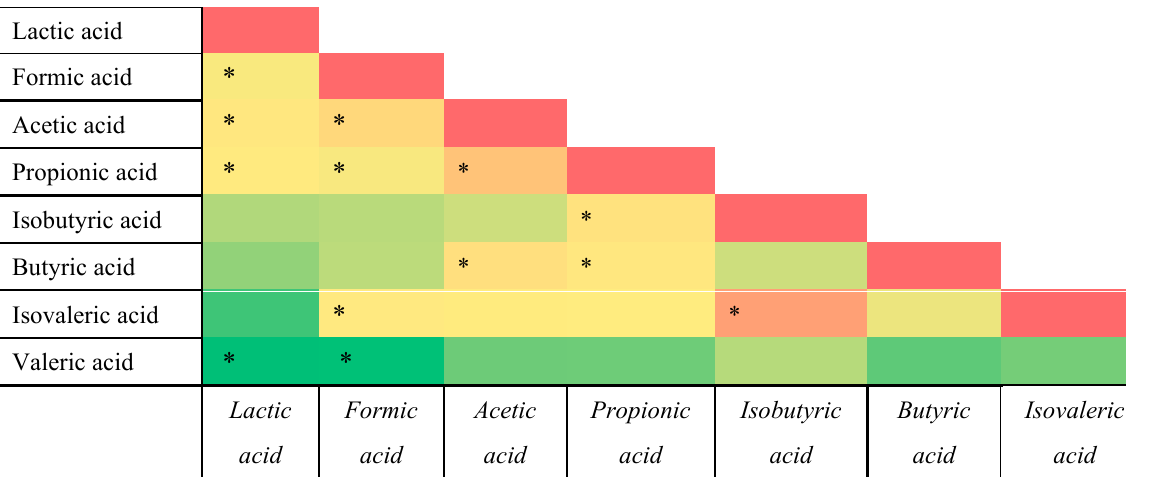
Figure 6. Pearson’s heatmap representing correlation between the concentrations of fatty acids. Green color represents negative correlation, whereas orange-red represents positive correlation. *: ( p < 0.05).